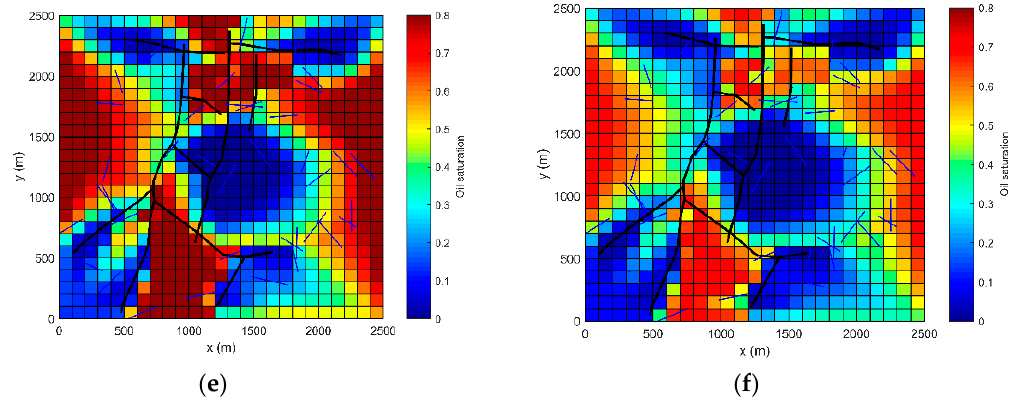
Figure 16. Profiles of oil saturation after 7300 days’ injection for Case 4 of: ( a ) the top layer of the non-fracture reservoir; ( b ) the bottom layer of the non-fracture reservoir; ( c ) the top layer of the reservoir with only main fractures; ( d ) the bottom layer of the reservoir with only main fractures; ( e ) the top layer of the reservoir with all fractures; and ( f ) the bottom layer of the reservoir with all fracture.